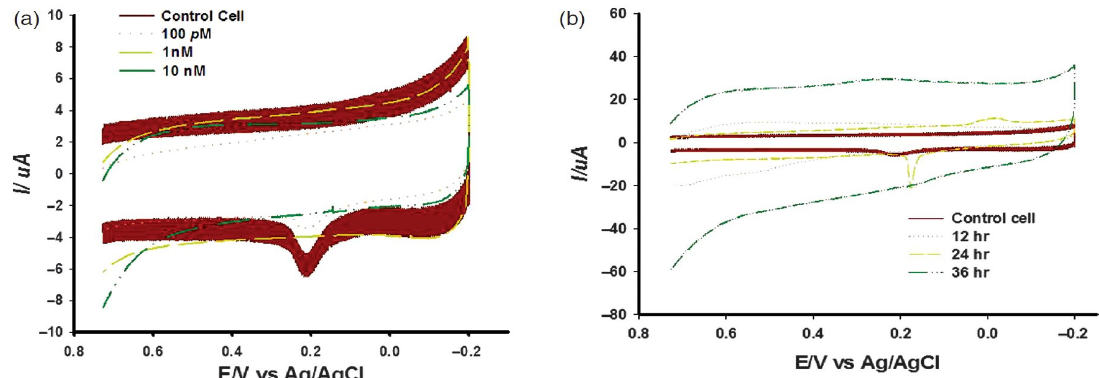
Figure 12. Effect of imidazolidinyl urea on skin fibroblast cells, ( a ) Cyclic voltammogram for skin fibroblast cells treated with different doses of imidazolidinyl urea; ( b ) Cyclic voltammogram for skin fibroblast cells detected at different times after imidazolidinyl urea treatments. Reproduced with permission from [31], Copyright 2012, American Scientific